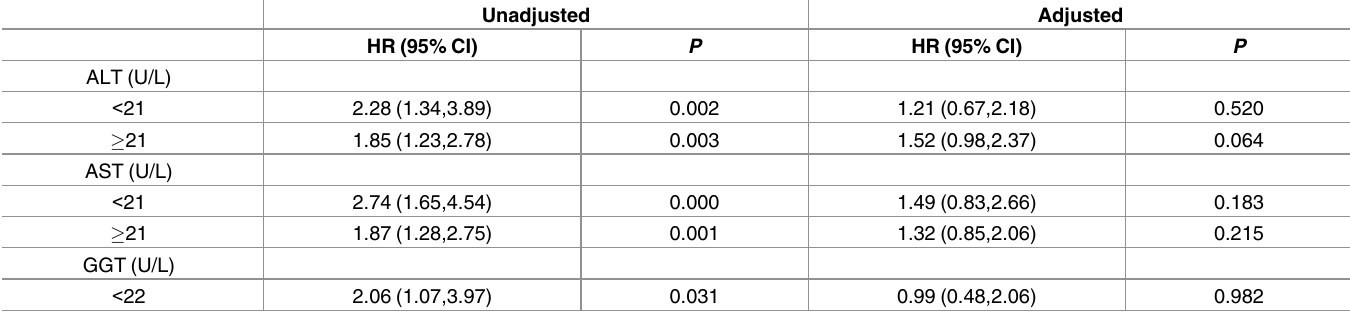
Table 6. Stratified analysis on the association between FLI and asymptomatic IVBS according to ALT, AST and GGT in longitudinal study (FLI < 30 vs FLI (cid:21) 30).